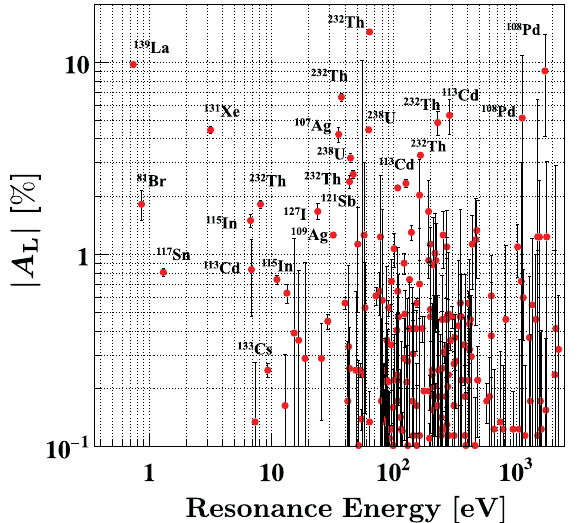
Figure 1. Large enhanced parity violation in several nuclei. The vertical axis is the longitudinal asymmetry of the neutron absorption cross section at a p-wave resonance. The horizontal axis is resonance energy of the p-wave resonance.